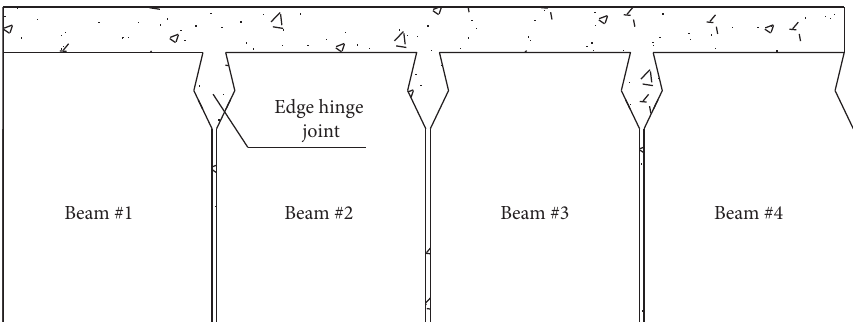
Figure 5: Cross section sketch of the model bridge.